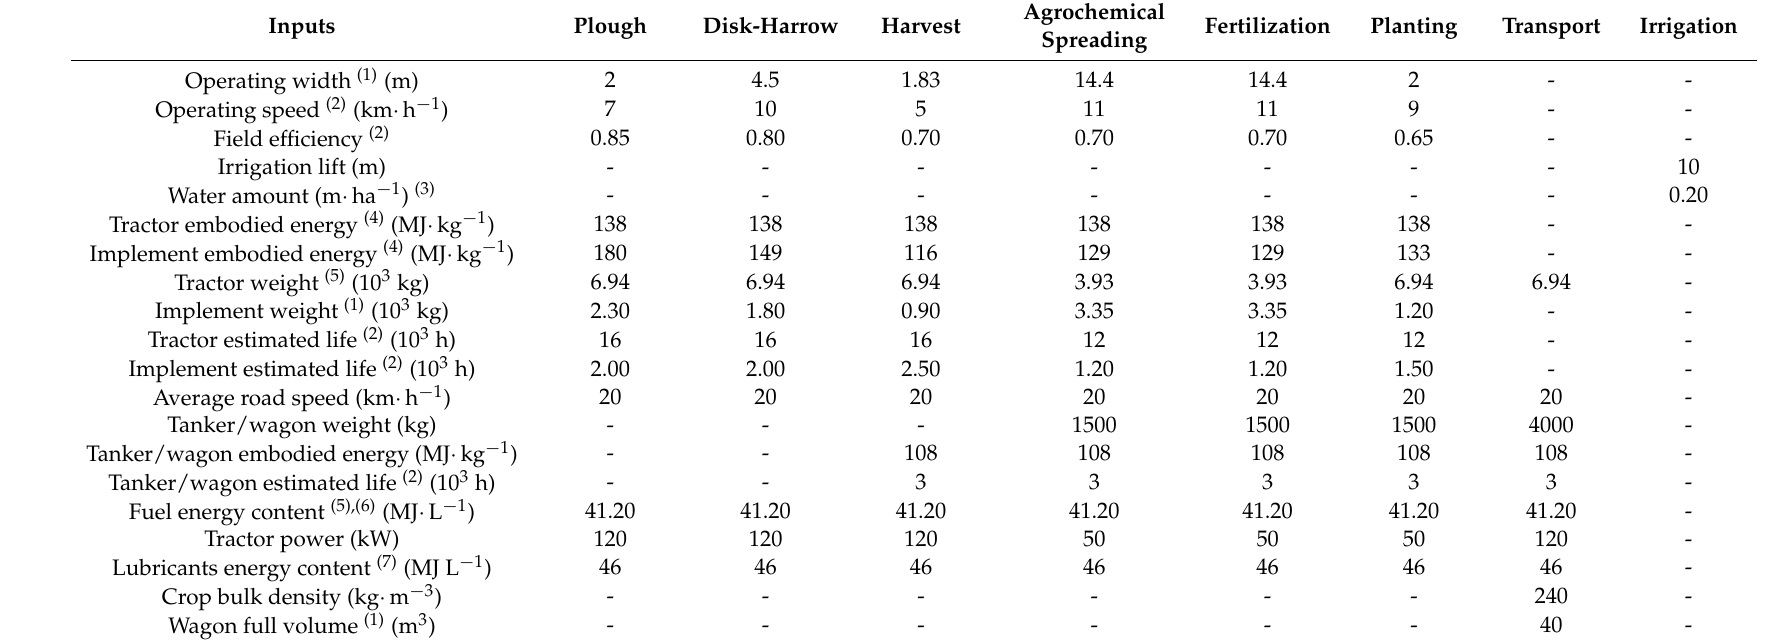
Table 2. Inputs per farm